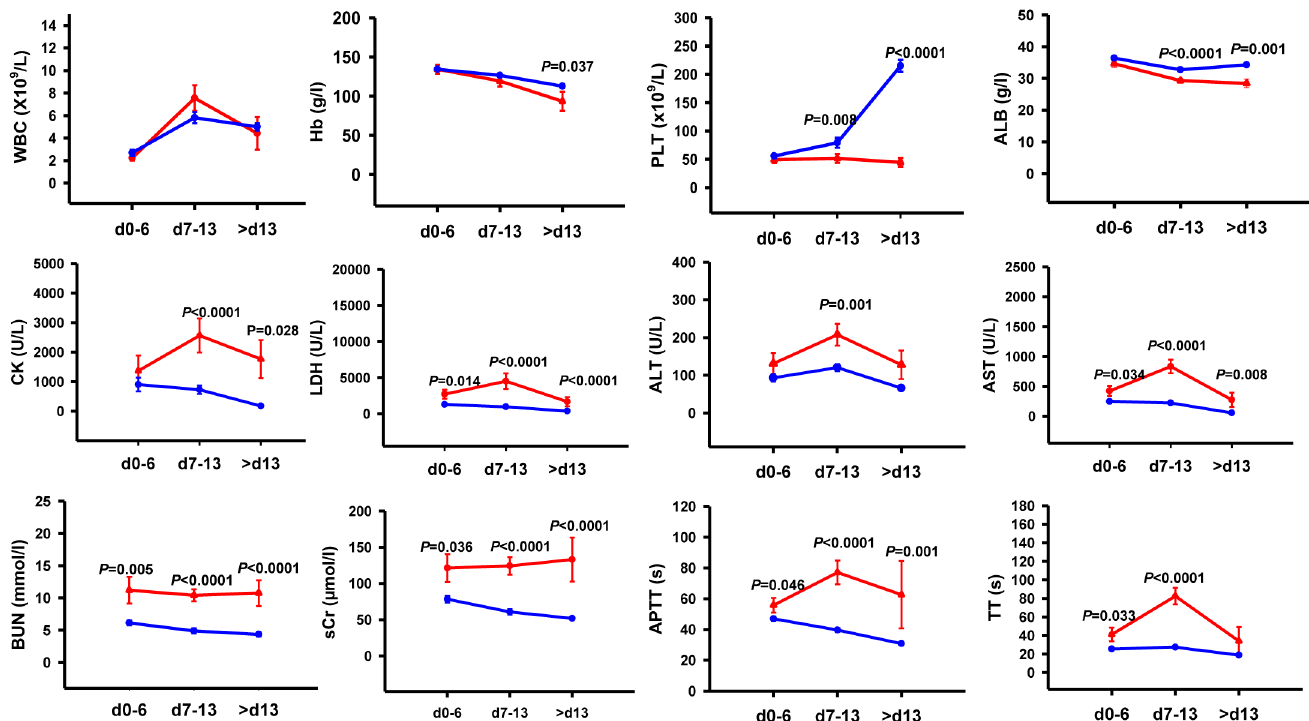
Fig 1. Changes in laboratory parametersat 3 periods in 142 patients with severefever with thrombocytopenia syndrome. WBC, white blood cell; Hb, hemoglobin; PLT, plateletcounts; Alb, serum albumin; LDH, lactate dehydrogenase; CK, creatininekinase; AST, serum aspartate aminotransferase; ALT, serum alanineaminotransferase; TT, thrombin time; APTT, activated partial thromboplastin time; BUN, blood urea nitrogen; sCr, serum